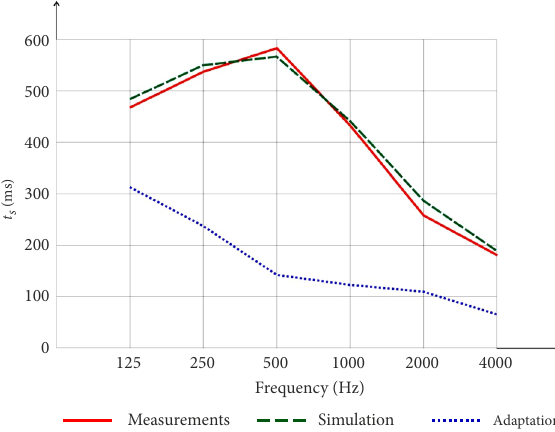
Figure 13. Graph depicting center time t S in the frequency function – comparison of in situ measurements, simulation